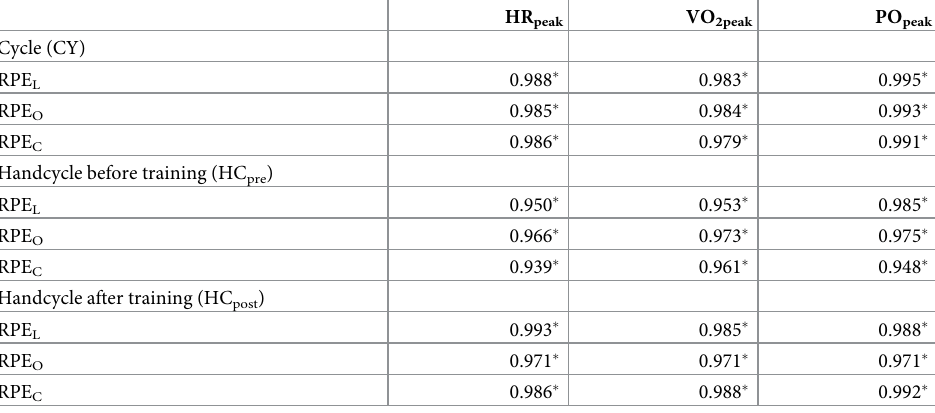
Table 2. Spearman correlation coefficients of RPEs and cardiorespiratory markers during cycle, and before and after handcycle training. HR peak VO 2peak PO